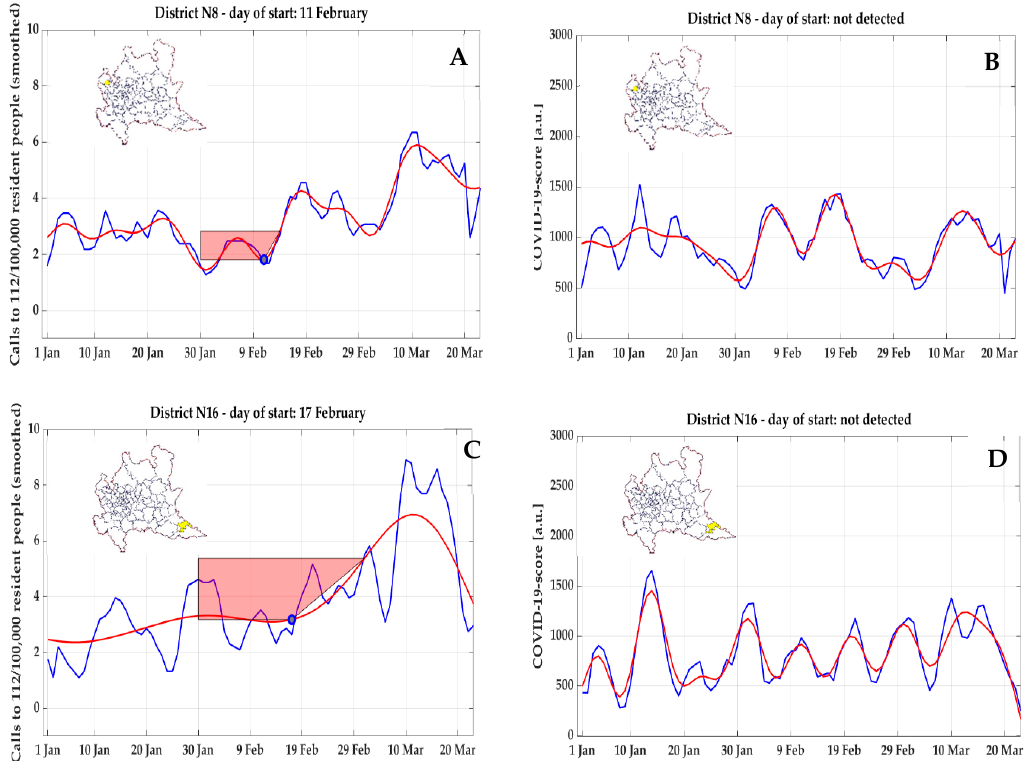
Figure 13. For cluster #8: ( A ) COVID-19-score time series with identified inflection point (blue dot, see text for details); ( B ) normalized emergency calls (NEC, N calls / 100,000 residents) time series with identified inflection point. For cluster #16: ( C ) COVID-19-score time series with identified inflection point (blue dot, see text for details); ( D ) normalized emergency calls (NEC, N calls / 100,000 residents) time series with identified inflection point. The early start days in the two clusters according to NEC were not confirmed by COVID-19 score, for which no start day could be detected.